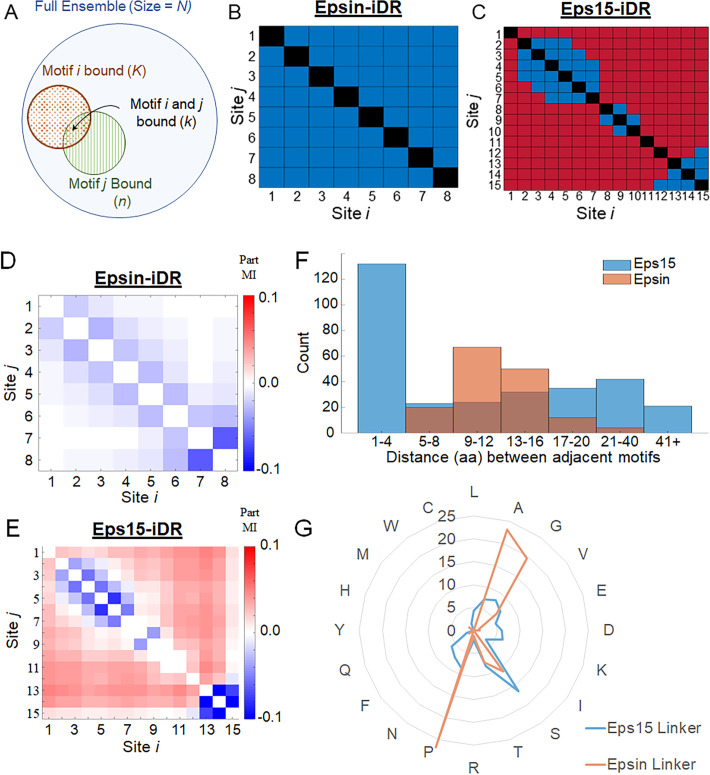
Eps15-iDR, but not Epsin-iDR, shows a statistical tendency toward co-accessibility of AP2α binding motifs.Schematic of the variables involved in the hypergeometric distribution to compute statistical co-accessibility. (B) Map showing whether the hypergeometric test shows independence (blue, p > 0.05) or a statistically significant tendency for co-accessibility (red, p < 0.05), for each pair of motifs (i, j) in the Epsin-iDR (C) same as B but for the Eps15-iDR. In the case of Eps15-iDR, multiple pairs of binding motifs were found to be statistically co-accessible. (D) Map showing partial mutual information (Part MI) for pairs of sites (i, j) in the Epsin-iDR. Positive values of Part MI (red) indicate that binding at i improves probability of binding at j. Negative values (blue) indicate that binding at i impairs binding at j and zero values (white) indicate no effect (E) same as D but for Eps15-iDR. (F) Histograms showing the distribution of inter-motif distances (i.e., distances between sequentially adjacent AP2α-binding motifs) in Epsin (Orange) and Eps15 (Blue) for all the species listed in S1 Text. Most neighboring motifs in Eps15 are within 1–4 residues of each other, while in Epsin, most are separated by 9–16 residues. (G) The amino acid composition of the sequences between adjacent binding motifs (linkers) in Epsin (orange) and Eps15 (blue). The linkers in Epsin are enriched for the amino acids Proline (27%), Alanine (23%) and Glycine (19.5%).